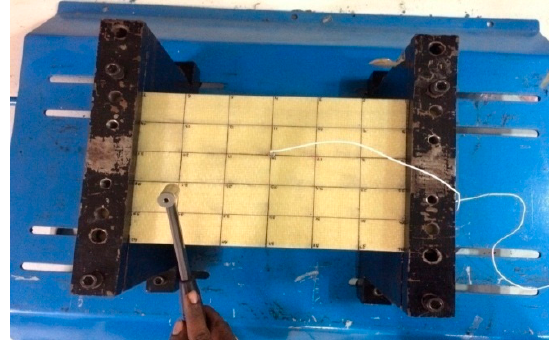
Figure 4. Experimental setup for the CFCF boundary condition.